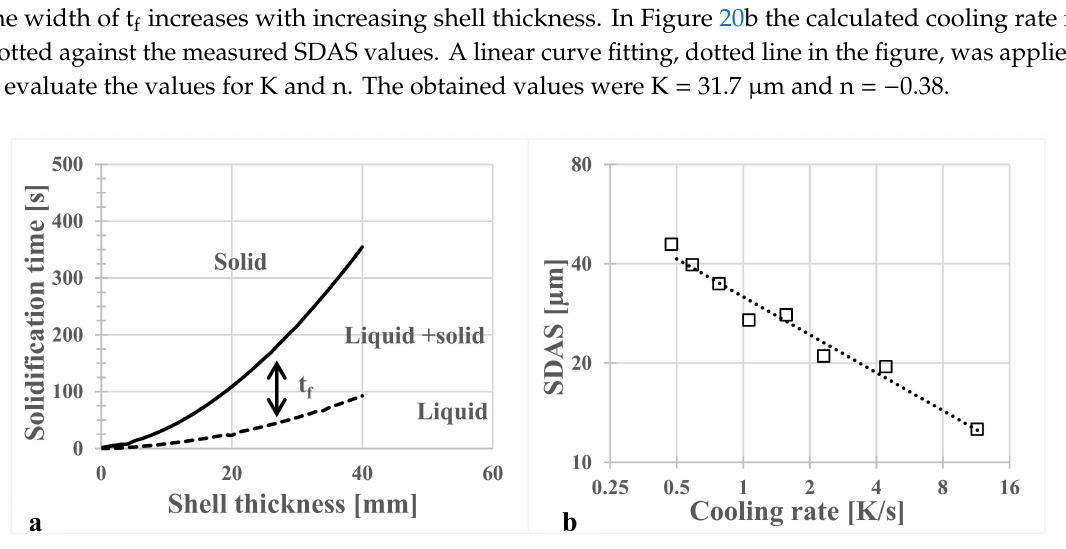
Figure 20. ( a )The calculated solidification time against shell thickness and ( b ) measured secondary dendrite arm spacing (SDAS) against calculated cooling